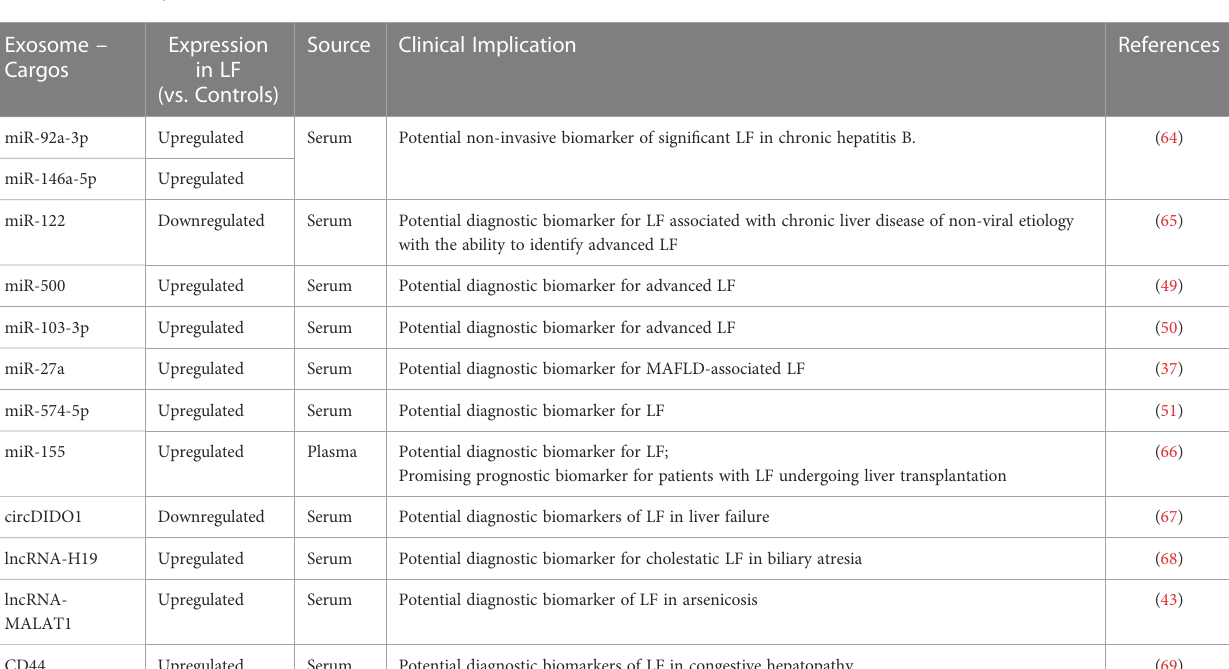
TABLE 1 Biomarker potential of exosomes in